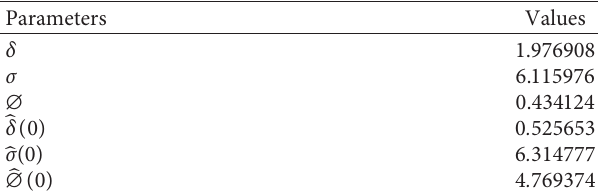
Table 2: Optimum values of the parameters in the adaptation laws.